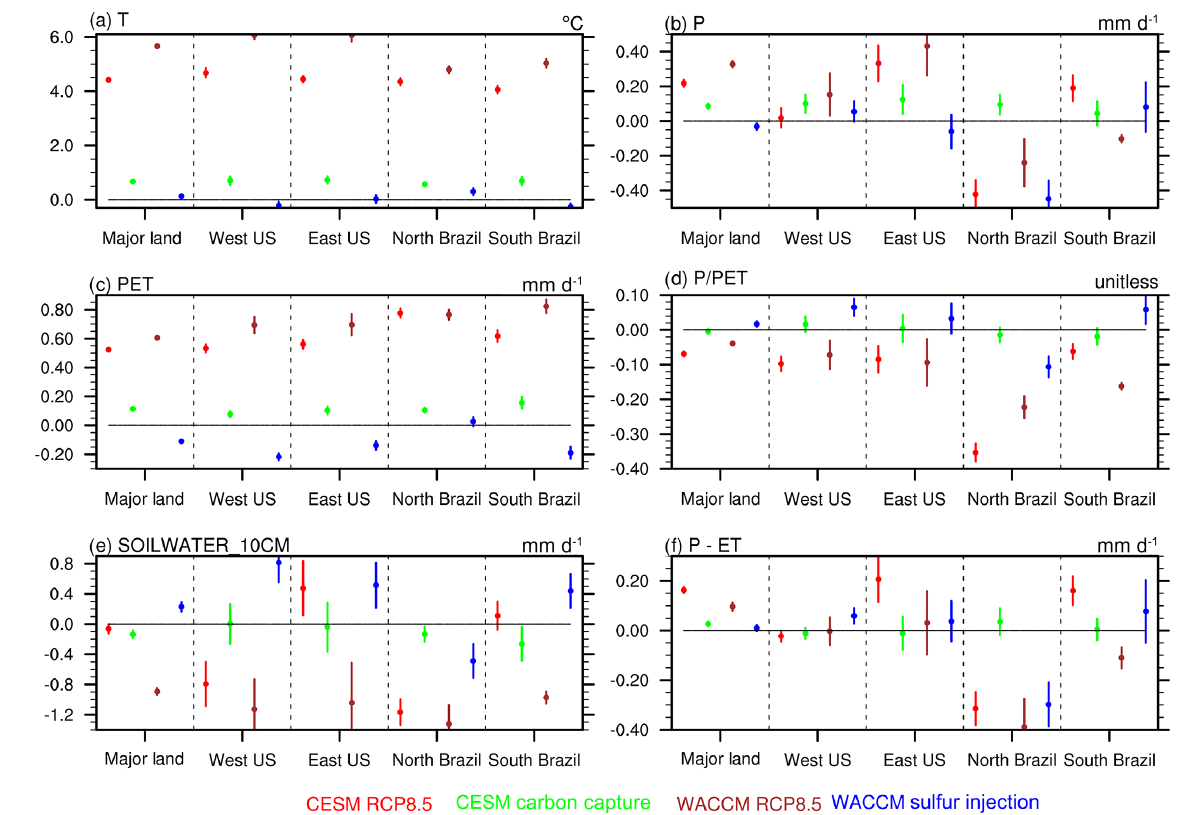
Figure 7. Regional changes at the end of the century relative to the present day. The western and eastern US are separated by 100 ◦ W, and northern and southern Brazil are separated by 10 ◦ S. See the boxes in Fig. 5a for the domains. The zero lines of the y axis indicate the present-day